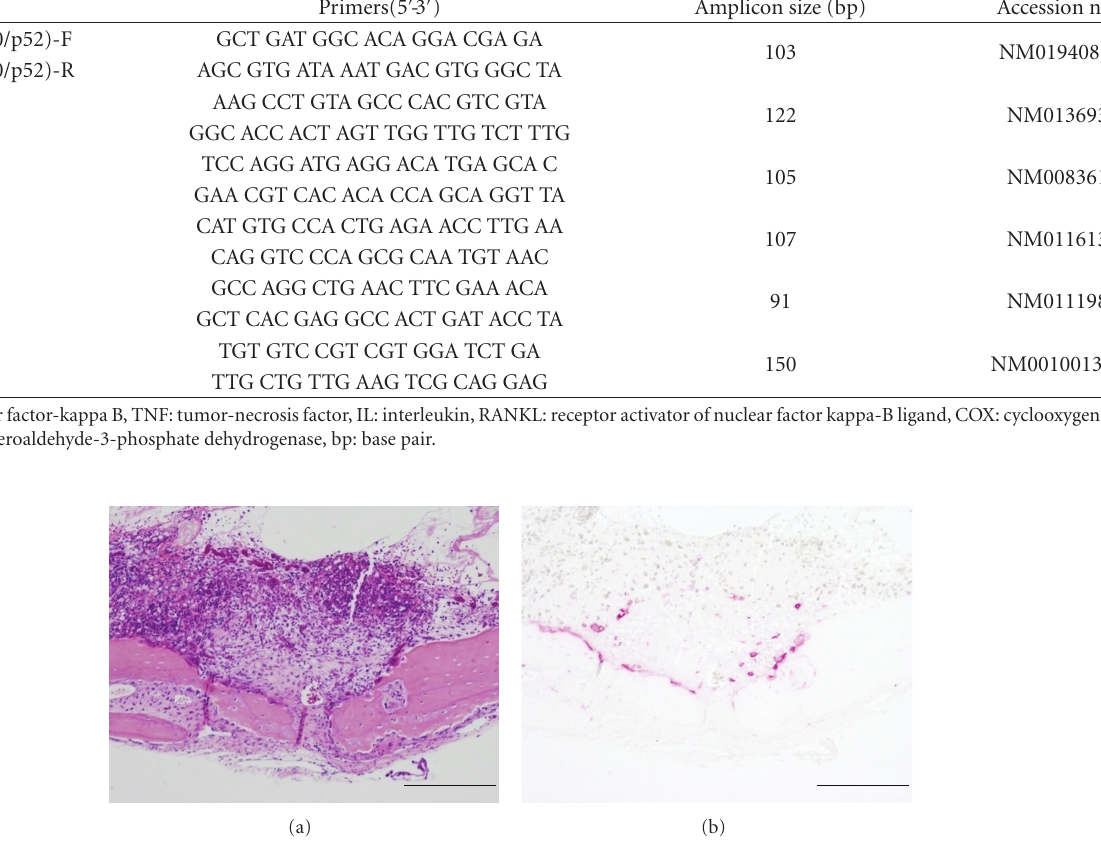
Figure 1: Histological analysis of murine calvaria retrieved on day 7 after PE particle implantation. Midfrontal sections of parietal bone were made as described in Section 2. Magnification x100 and scale bar represents 200 μ m in all figures. A representative of five murine calvarial samples is shown. (a) Hematoxylin/eosin (HE). (b) Tartrate-resistant acid phosphatase (TRAP)